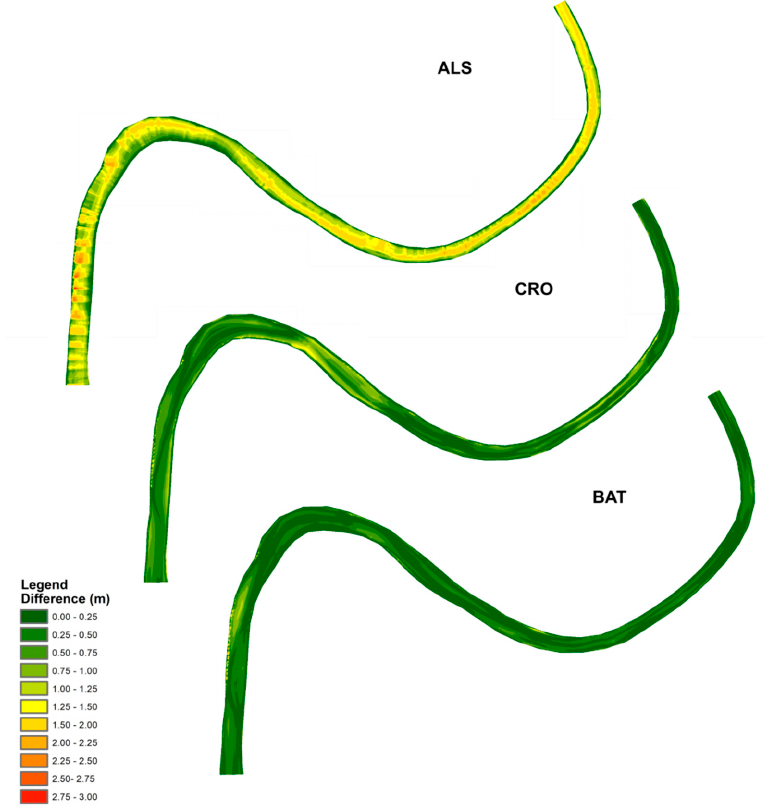
Figure 7. Error maps comparing evaluated digital elevation models (ALS, CRO, BAT) and the reference model (ADP).